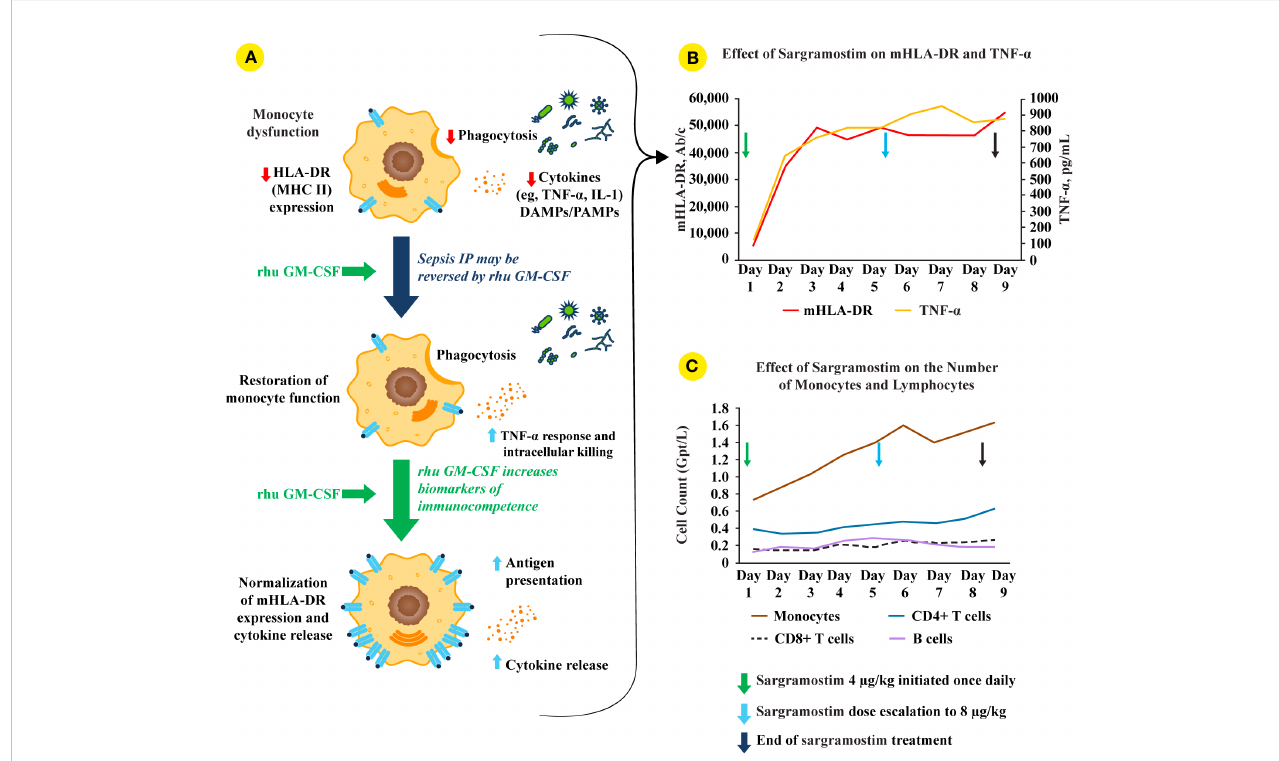
FIGURE 2 rhu GM-CSF (including sargramostim) stimulates and restores immune function in sepsis IP. (A; top monocyte) Impaired monocyte function leads to reduced pro-in fl ammatory mediator responses, decreased pathogen phagocytosis, and lower human leukocyte antigen-DR isotype (HLA-DR) expression (4). (A; middle and bottom monocytes) Treatment with recombinant human (rhu) granulocyte-macrophage colony-stimulating factor (GM-CSF) leads to increased intracellular killing, cytokine secretion, phagocytosis, monocyte (m)HLA-DR expression, and antigen presentation (2, 4). (B) In a biomarker- guided study of patients with sepsis IP (n=38), sargramostim was given daily for up to 8 days to patients with sepsis and mHLA-DR lower than 8000 Ab/c (31). Sargramostim treatment led to improved mHLA-DR expression and tumor necrosis factor (TNF)- a responses. (C) Sargramostim increased absolute numbers of monocytes and lymphocyte subsets (e.g., CD4+ T cells, CD8+ T cells, B cells) (31). Ab/c, antibody numbers bound per cell; DAMP, damage- associated molecular patterns; GM-CSF, granulocyte-macrophage colony-stimulating factor; HLA-DR, human leukocyte antigen-DR isotype; IL, interleukin; IP, immunoparalysis; MHC II, class II major histocompatibility complex; mHLA-DR, monocyte human leukocyte antigen-DR; PAMP, pathogen-associated molecular patterns; rhu, recombinant human; TNF, tumor necrosis factor.